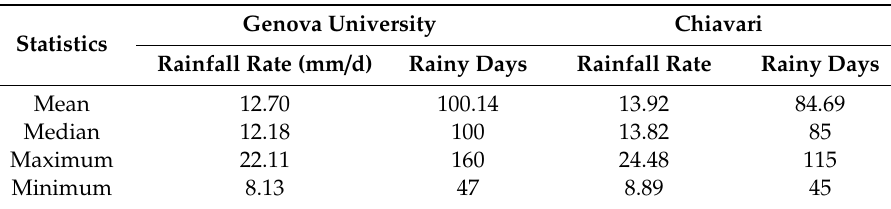
Chiavari (1877–2019) rain Table 5. Descriptive statistics of hourly rainfall at Genoa Ponte Carrega (1939–2019) and Chiavari (1932–2019) rain gauges.